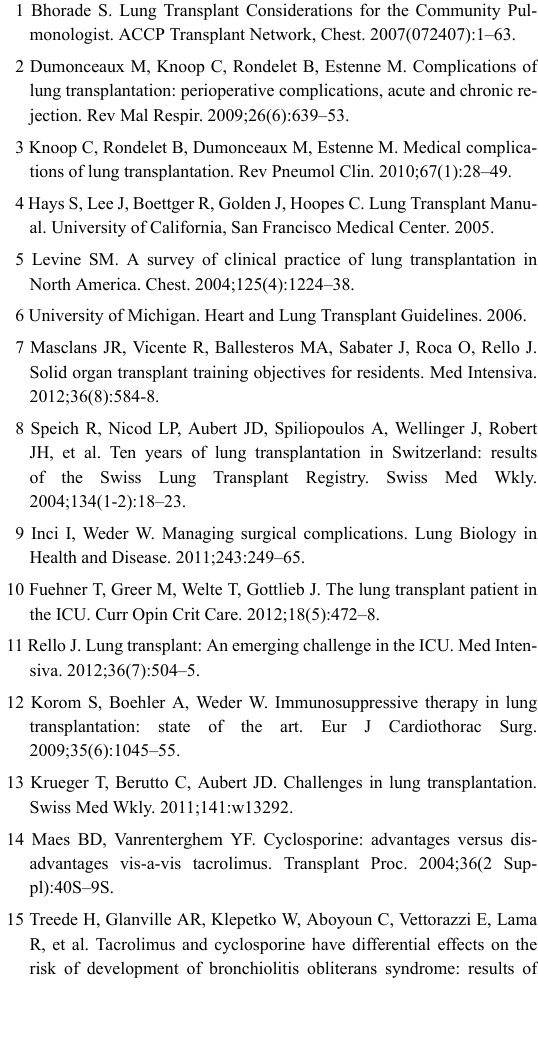
Table 5: Physiotherapy objectives and techniques used in the early postoperative phase after lung transplantation. Indication, objective and